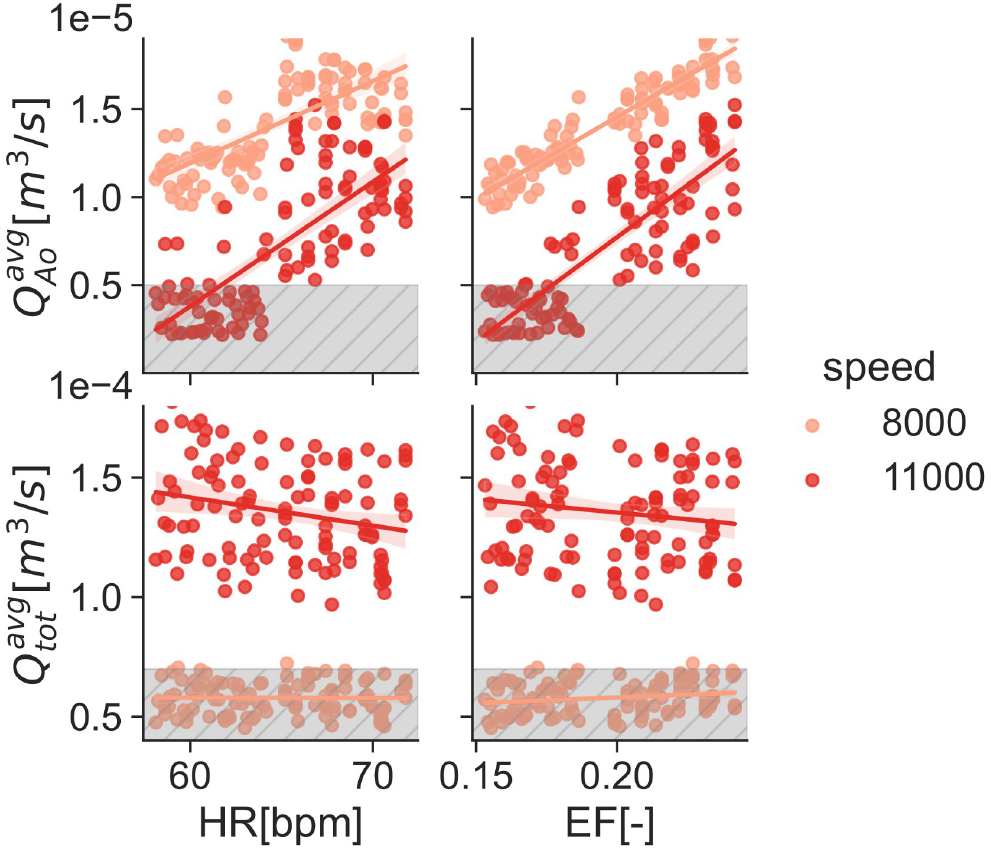
Fig 12. Aortic valve flow Q avg 8 k [ rpm ] and 11 k [ rpm ]. The grey hatched region represents the minimum limit for both Q avg